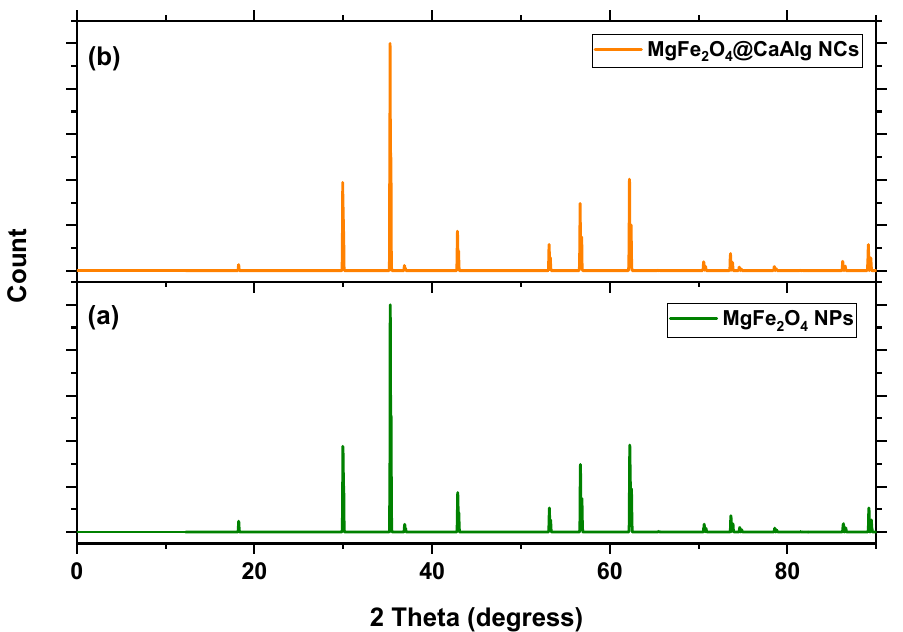
Figure 1. The XRD patterns of ( a ) green synthesized MgFe 2 O 4 NPs and ( b ) MgFe 2 O 4 @CaAlg NCs,